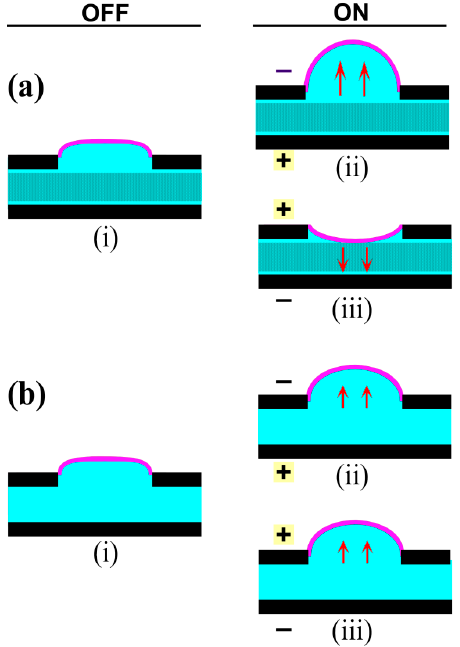
Figure 5. Schematic representation of fluidic actuation in the stacked layout. ( ai ) The actuator comprised an actuating membrane encapsulating the pumping fluid and a paper microchannel layer sandwiched between two electrodes; ( aii ) Application of negative voltage (100 V) to the top electrode caused membrane inflation; whereas ( aiii ) reversing polarity caused membrane depression; ( bi ) An actuator without the paper layer; ( bii ) Negative voltage on the top electrode caused membrane inflation, but to a lesser extent than in (a); as did ( biii ) the reverse